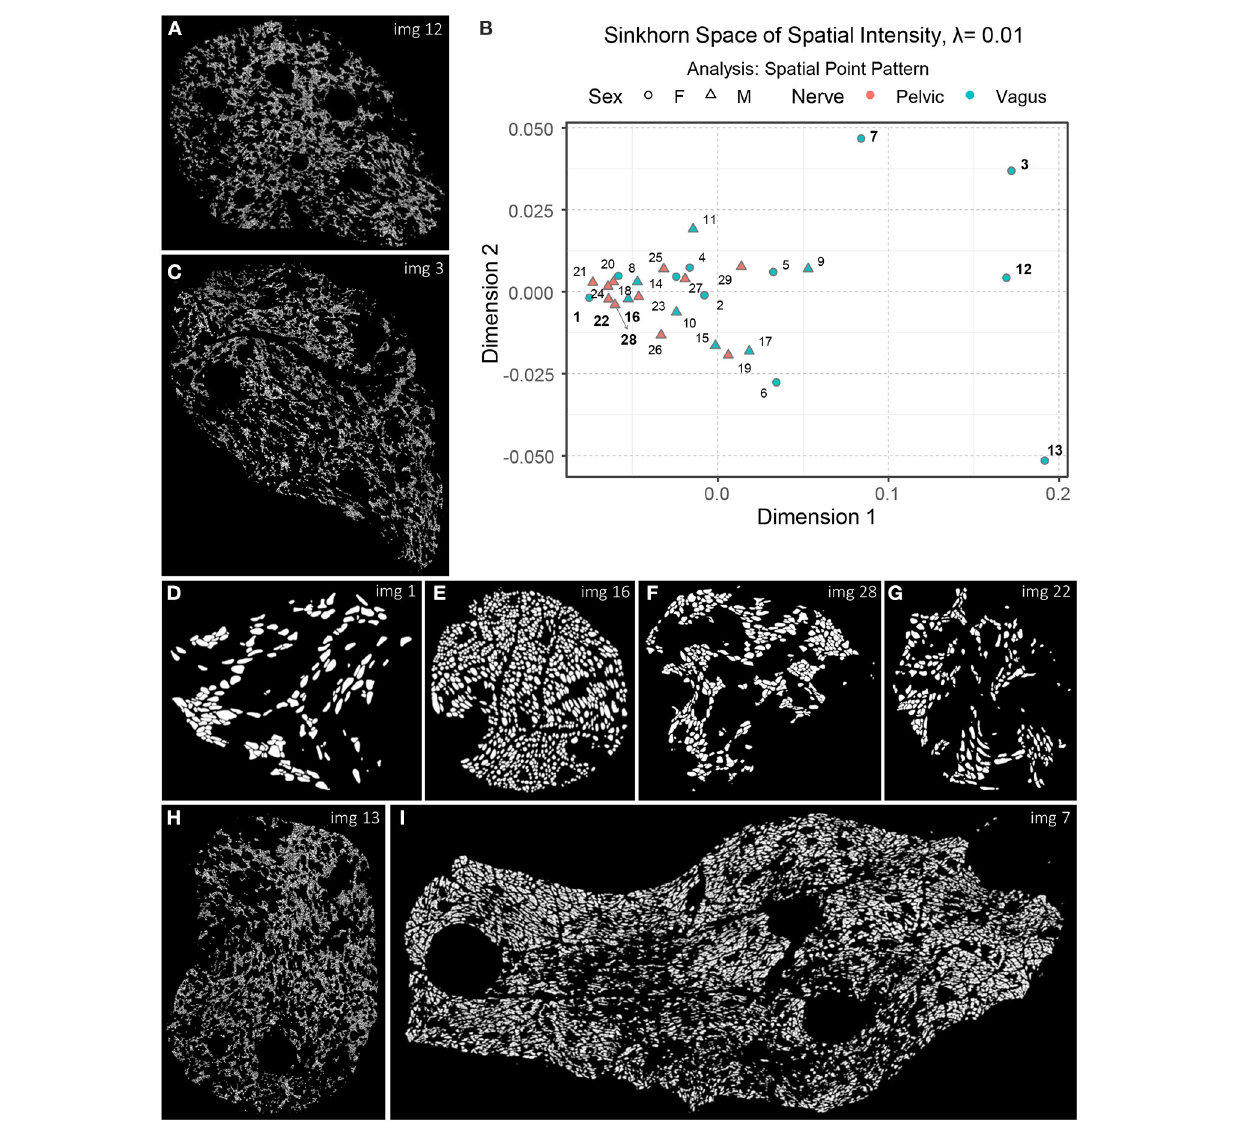
FIGURE9 (A, C–I) A set of images of the segmented unmyelinated axons in the nerve cross-sections, labeled with the Image ID. (B) An embedding of the spatial intensity of the spatial point patterns in the Sinkhorn space for entropic regularization parameter λ = 0.01. The vagus and the pelvic samples are shown in cyan and orange [circles for female (F) and triangles for male (M)], respectively, and labeled with the Image ID listed in Table